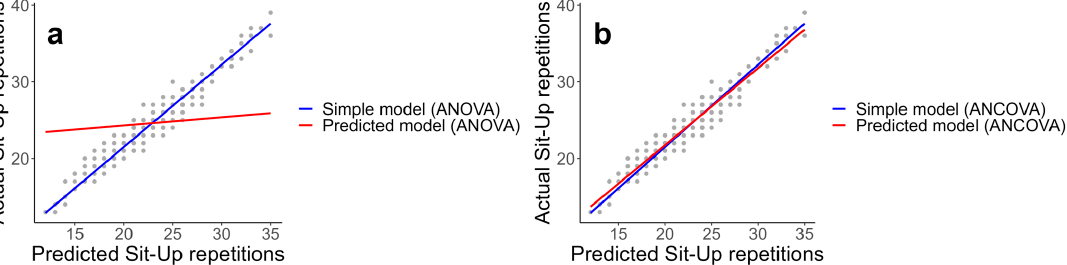
Figure 3. Example linear regression fitted to actual and predicted sit-up repetitions. The R 2 value was 0.11 and 0.95 for ANOVA ( a ), and ANCOVA ( b ) models, respectively. In this example, the high R 2 and slope values suggest that the ANCOVA model was appropriate for predicting the actual sit-up